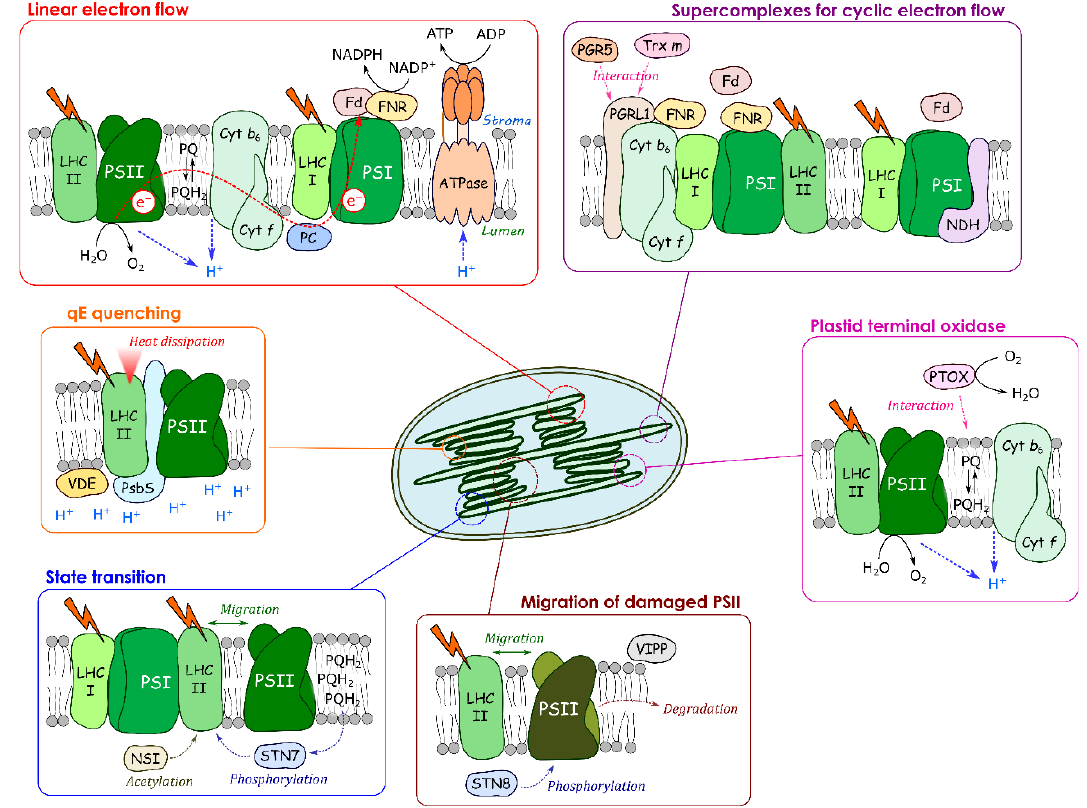
Figure 2. Dynamic changes of protein–membrane association for regulating photosynthetic electron transport. Photosynthetic linear electron flow produces NADPH and ATP for CO 2 assimilation in the grana margin. In the grana, heat dissipation at the light-harvesting complex (LHCII), the so-called qE quenching, occurs, and the damaged PSII migrates and is digested; In the grana margin, STN7 and NSI stimulate the state transition. PTOX changes its localization in response to stroma pH to maintain the PQ redox poise. A part of PSI forms supercomplexes with PGRL1, FNR and NDH in the stroma lamellae.